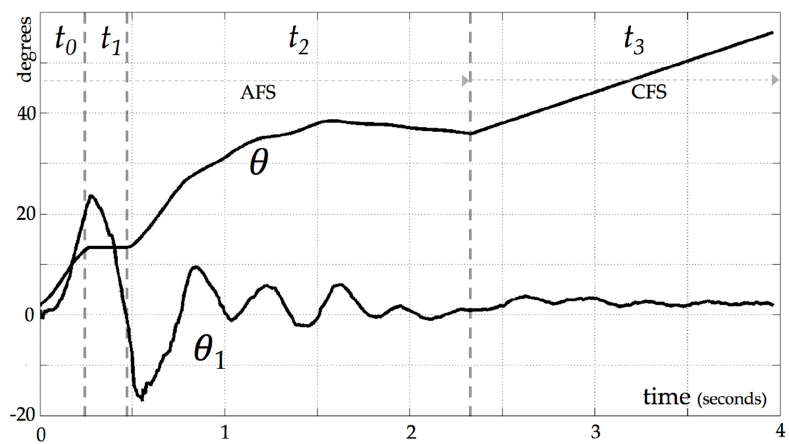
θ to be used by an